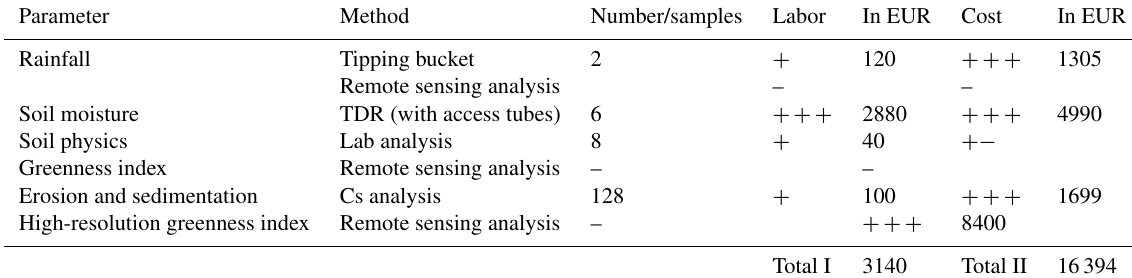
Table A6. Kenya Case, scenario 3: to maximize remote sensing analysis. Parameter Rainfall